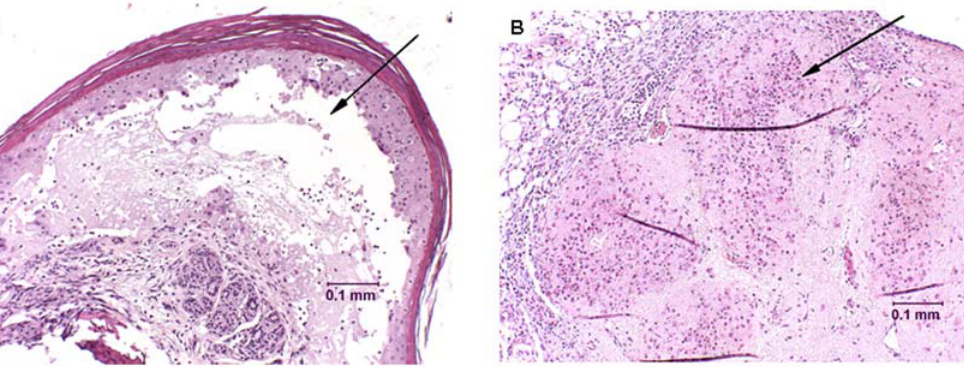
Figure 7. Histological sections from mice infected with MPXV-USA-2003 stained with hematoxylin and eosin. A) Necrosis of ovarian follicles (arrow) with subacute inflammation infiltrating surrounding connective tissue and peri-ovarian fat. B) Skin of foot with intradermal bulla containing edema and cell debris (arrow). Surrounding epidermis is undergoing ballooning degeneration.